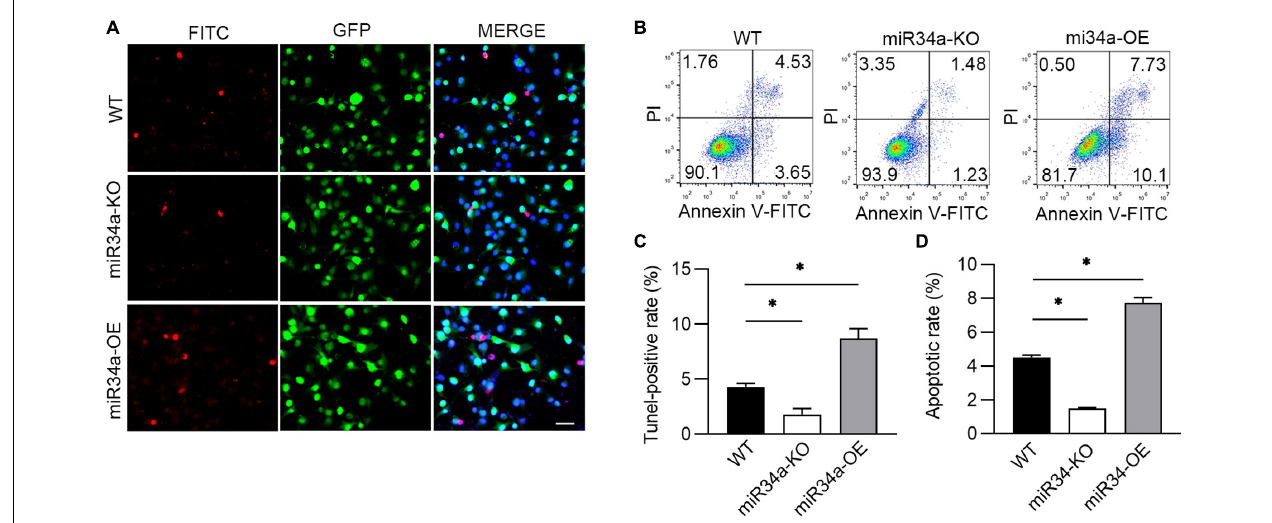
FIGURE 3 | miR34a promoted A549 apoptosis induced by hyperoxia. (A) WT, miR34a-OE, and miR34a-KO A549 cell was staining by TUNEL-FITC (Red) after culture in slice and treated with hypoxia, and (C) its statistical result. (B) WT, miR34a-OE, and miR34a-KO A549 cell apoptotic rate was examined by flow cytometry and its statistical result (D) . One-way ANOVA, ∗ p < 0.05 vs. WT, n = 5.